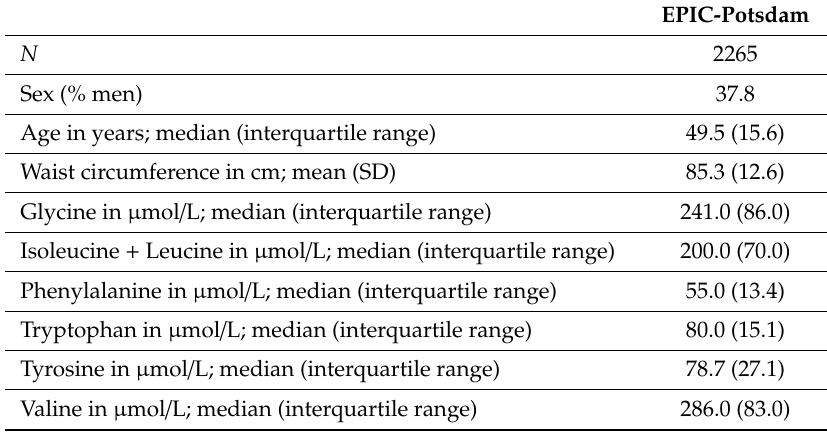
Table 1. Baseline characteristics, European Prospective Investigation into Cancer and Nutrition (EPIC)-Potsdam random